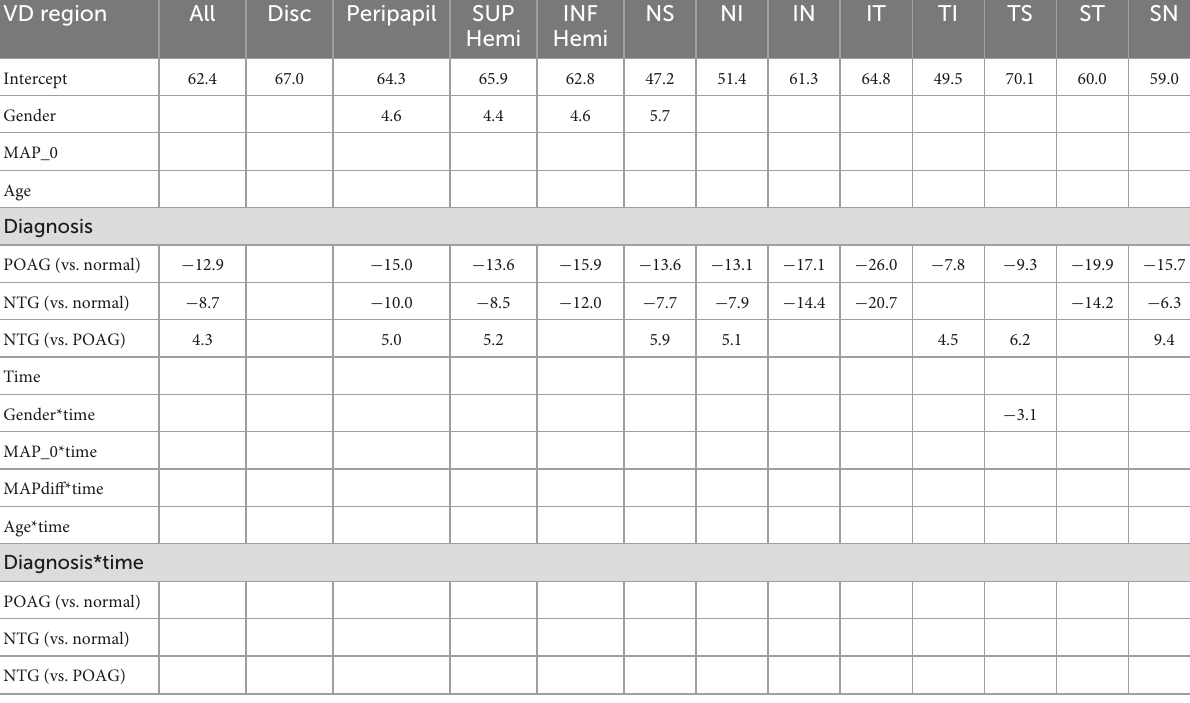
TABLE 3 Optic nerve head vessel density optical coherence tomography angiography (OCTA) adjusted linear mixed model estimates (%). VD